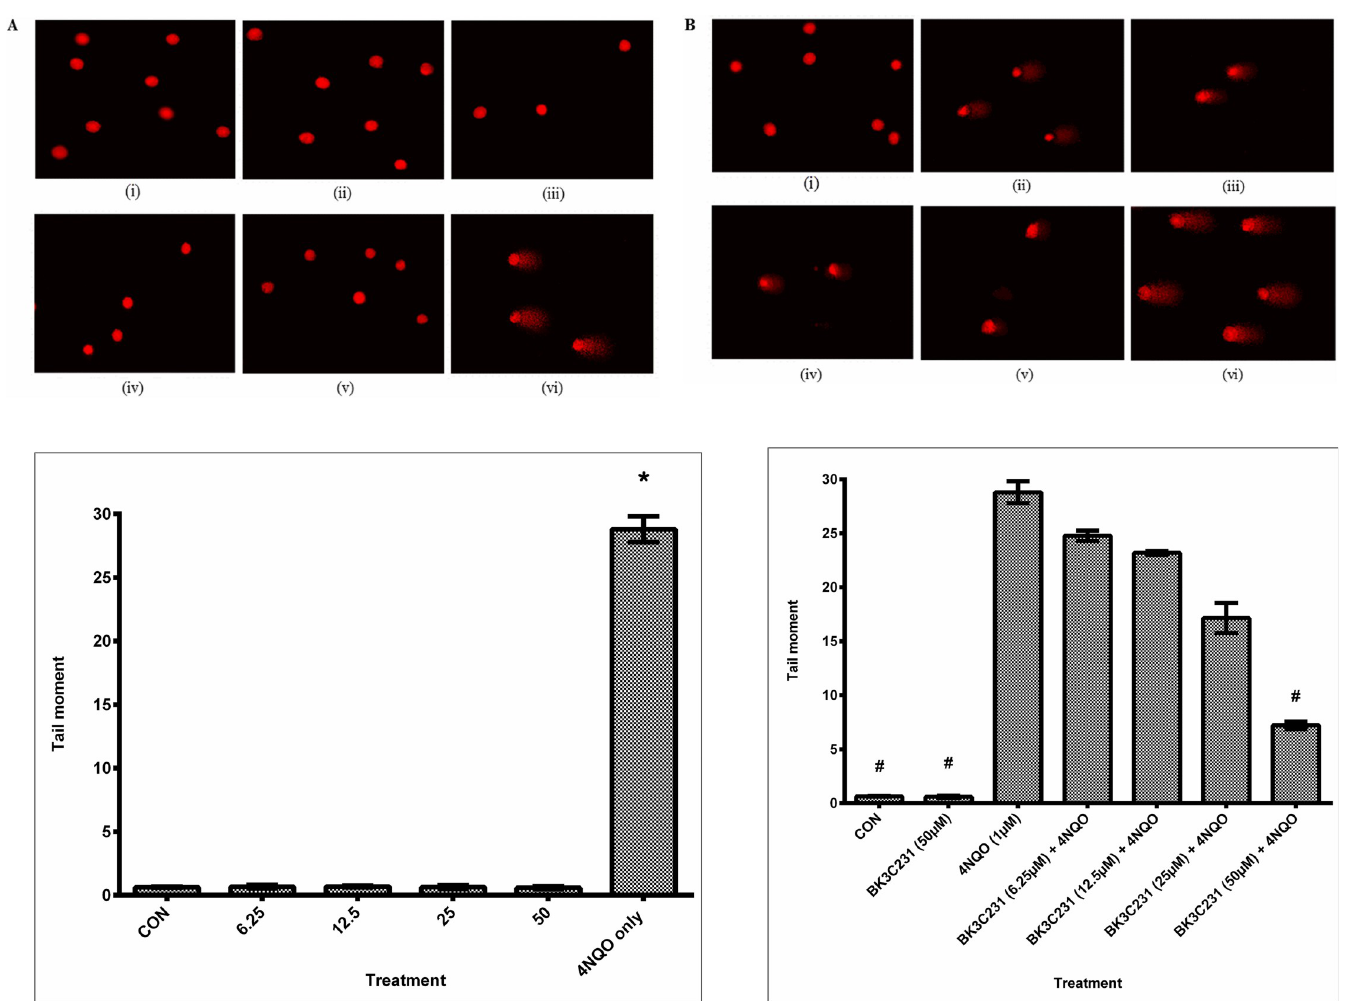
Fig 3. DNA microlesion assessment in CCD-18Co cells using alkaline comet assay. (A) Fluorescence microscopic images with EtBr staining of untreated cells (i), cells treated with BK3C231 at 6.25 μ M (ii), 12.5 μ M (iii), 25 μ M (iv) and 50 μ M (v) for 24h and cells treated with 4NQO at 1 μ M for 1h (vi). (B) Fluorescence microscopic images of untreated cells (i), cells treated with BK3C231 at 6.25 μ M (ii), 12.5 μ M (iii), 25 μ M (iv) and 50 μ M (v) for 2h prior to 4NQO induction at 1 μ M for 1h and cells treated with 4NQO at 1 μ M for 1h (vi). (C) Screening for DNA damage expressed as tail moment in cells treated respectively with BK3C231 from 6.25 μ M till 50 μ M for 24h and 4NQO at 1 μ M for 1h. (D) Cells were pretreated with BK3C231 from 6.25 μ M till 50 μ M for 2h prior to 4NQO induction at 1 μ M for 1h. Each data was obtained from three independent experimental replicates and each data point in (C) and (D) was expressed as mean ± SEM of tail moment. � p < 0.05 against negative control, CON (C) and # p < 0.05 against positive control, 4NQO only